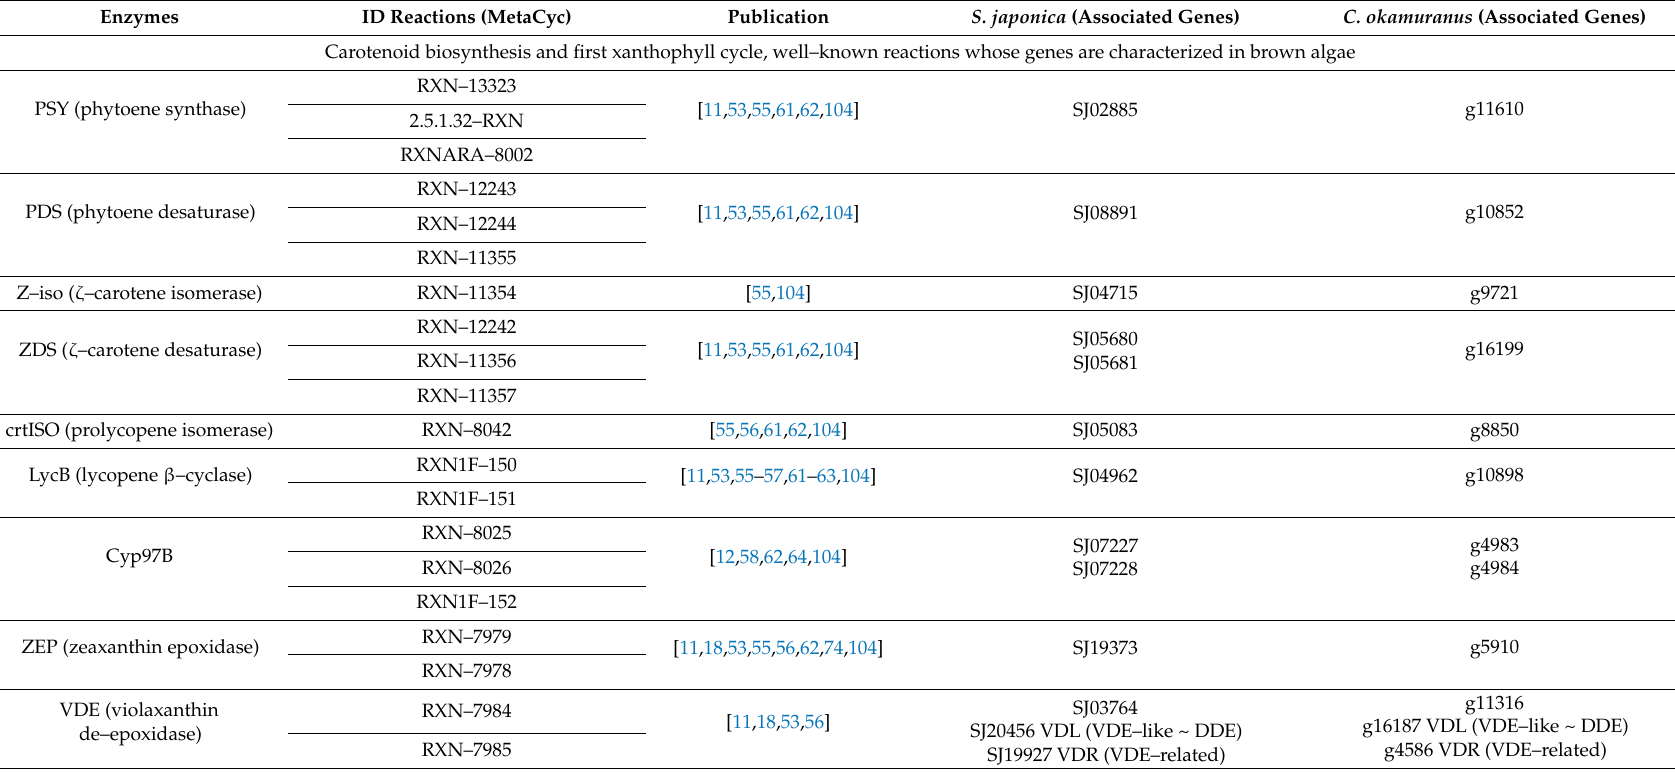
Table A1. List of manual modifications made to the GSMNs of S. japonica and C. okamuranus